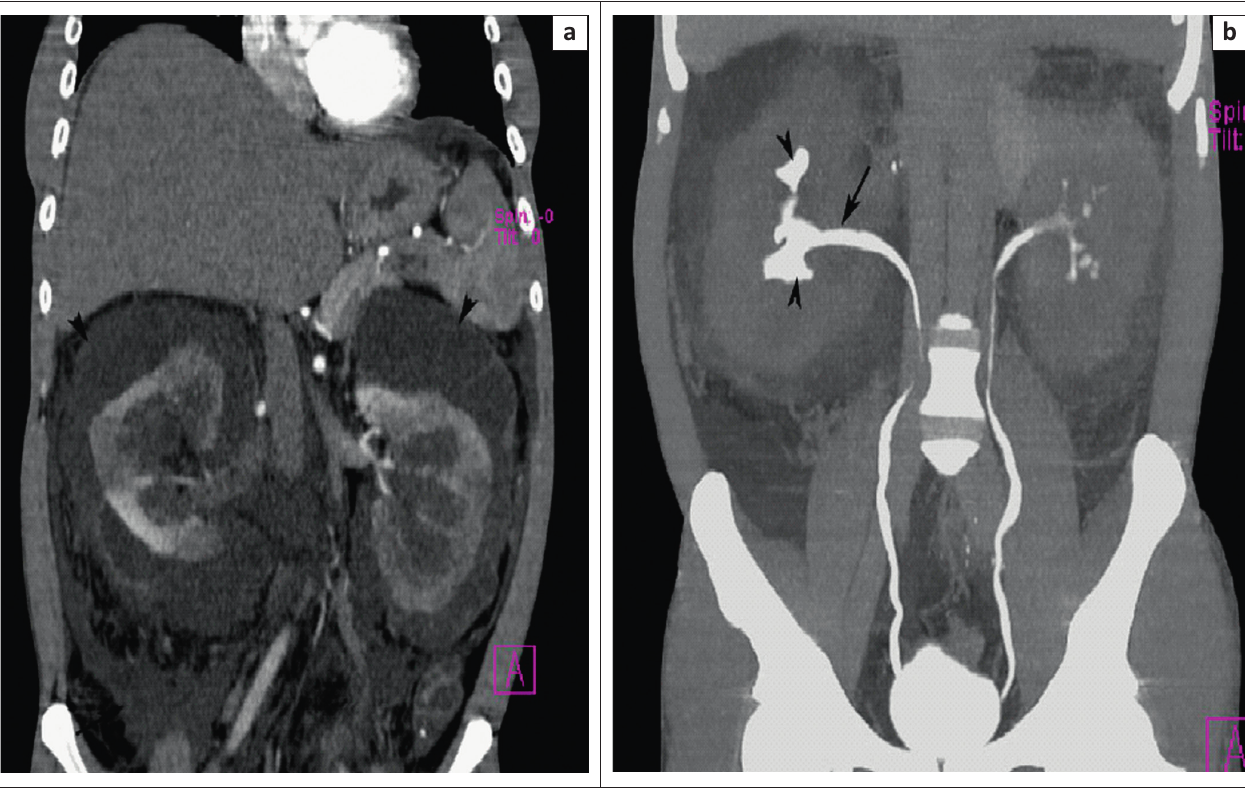
FIGURE 2: Reformatted (a) coronal contrast enhanced CT scan in the corticomedullary phase. Bilateral enlarged kidneys with perinephric collection (arrowheads). Reformatted (b) maximum intensity projection CT urography. Medial deviation of the proximal right ureter posterior to the IVC, swinging back to the normal course distally, consistent with retrocaval ureter (arrow).